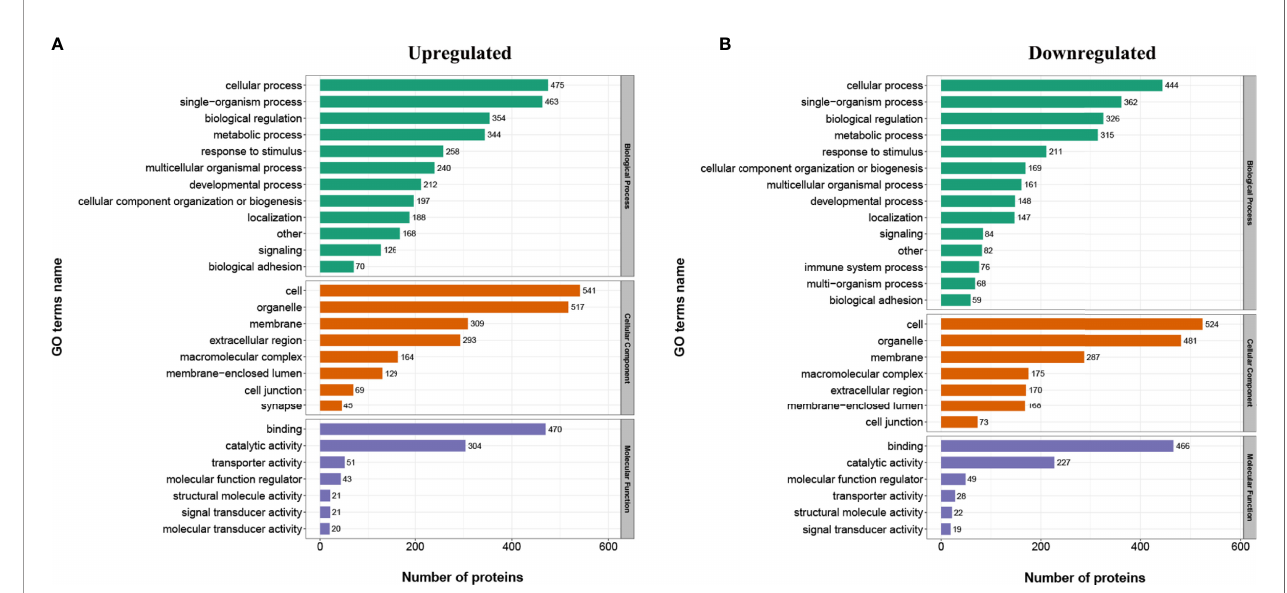
FIGURE 3 | Gene ontology (GO) analysis for the identi fi ed differentially expressed proteins (DEPs). The DEPs were annotated into three categories based on GO terms, including biological processes, cellular components, and molecular functions. (A) GO enrichment analysis of the upregulated DEPs. (B) GO enrichment analysis of the downregulated DEPs.